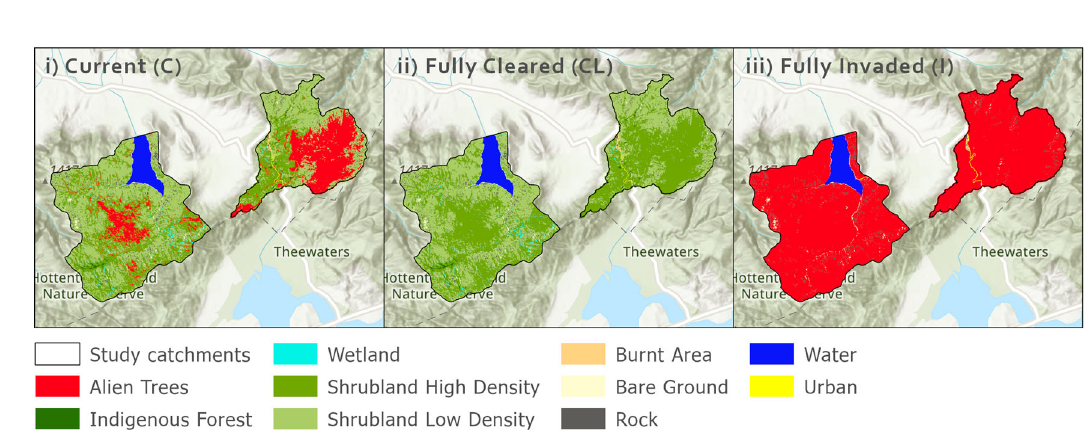
Fig. 3 Invasive alien tree (IAT) states. The three IAT landscape states used in the hydrological modelling (i) Current (C) state which re fl ects invasion levels present during the drought (2015 – 2017); (ii) Fully Cleared (CL) state representing all IATs cleared; and (iii) fully Invaded (I) state representing lack of maintenance of cleared areas and spread to full catchment invasion. Base map: Esri, NASA, NGA, USGS, Esri South Africa, Esri, HERE, Garmin, FAO, METI/NASA,